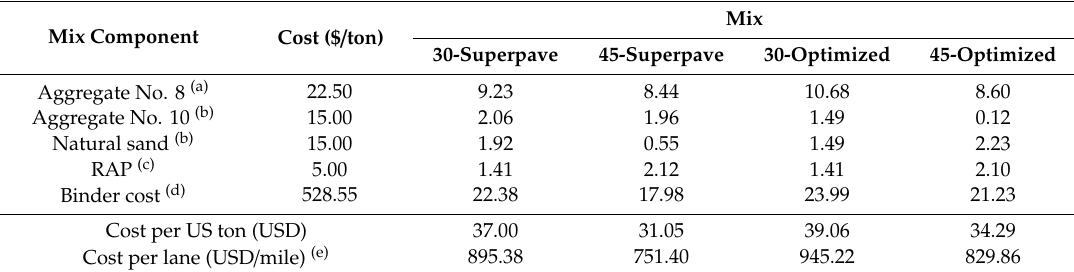
Table 3. Mixes’ cost